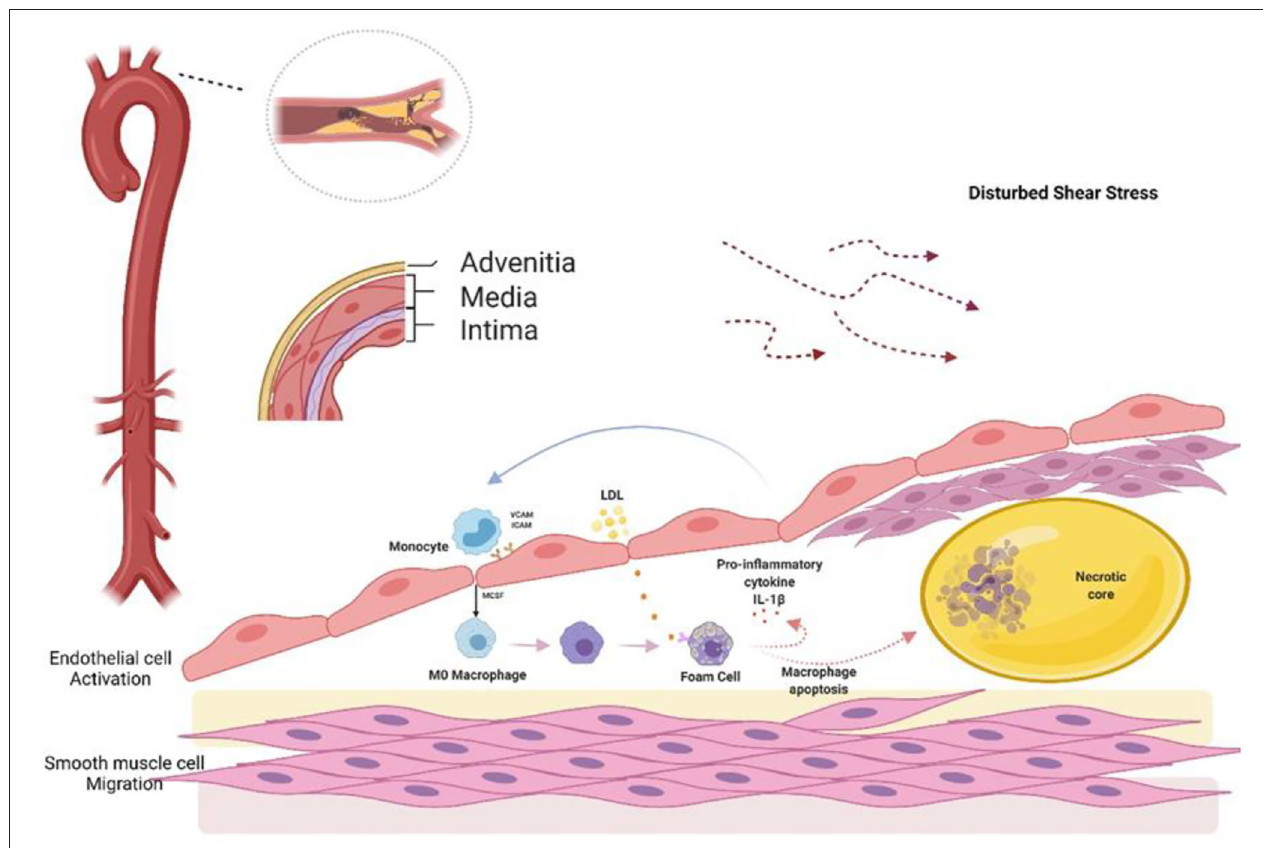
FIGURE 1 | Atherosclerosis begins with endothelial cell activation. The normal arterial wall contains a three-layered structure, with the intima consisting of wellarranged endothelial cells that perform important physiological functions. Endothelial cells normally have anti-inflammatory, anti-proliferative, and antioxidant status. When subjected to shear stress, the endothelium is activated, allowing large numbers of monocytes and LDL to enter the endothelium. In the endothelium, LDL is oxidized, amongst other modifications, and is, in turn, engulfed by macrophages formed by monocyte differentiation to form foam cells. Foam cells secrete pro-inflammatory factors, which promote endothelial cell-expressed ICAM and VCAM-mediated monocyte recruitment, creating a malignant closed loop. Finally, the apoptotic cells and lipids form a necrotic core, accompanied by smooth muscle cells that migrate over the necrotic core to form a fibrous cap. LDL, low-density lipoprotein; ICAM, intercellular cell adhesion molecule-1; VCAM, vascular cell adhesion